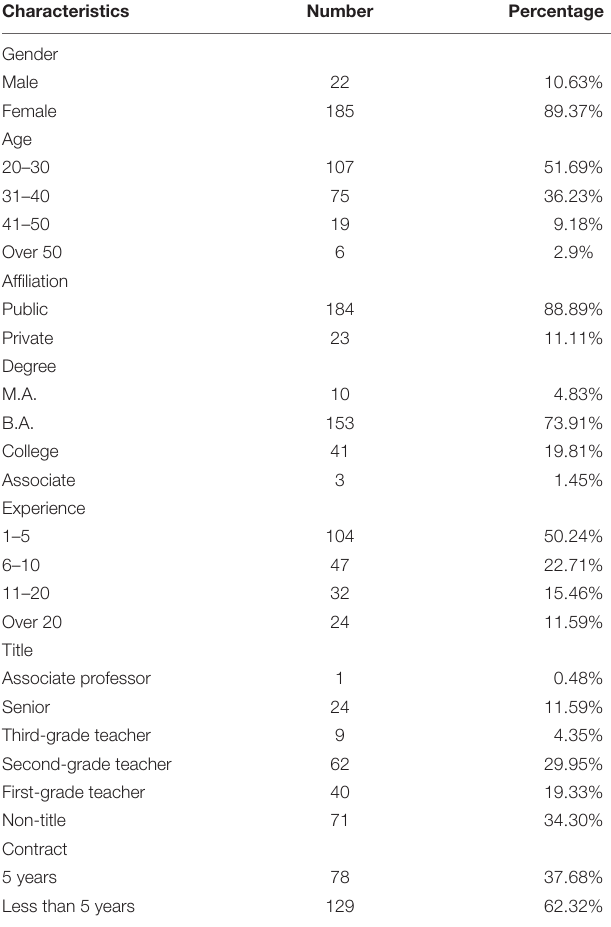
TABLE 1 | Demographical information of